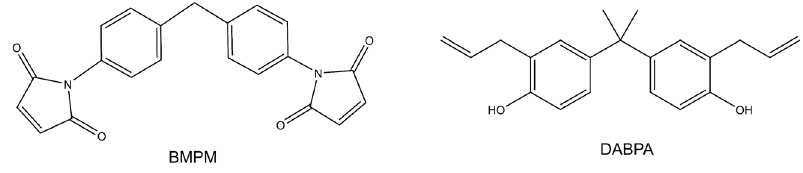
Figure 1. Molecular structure of BMI.